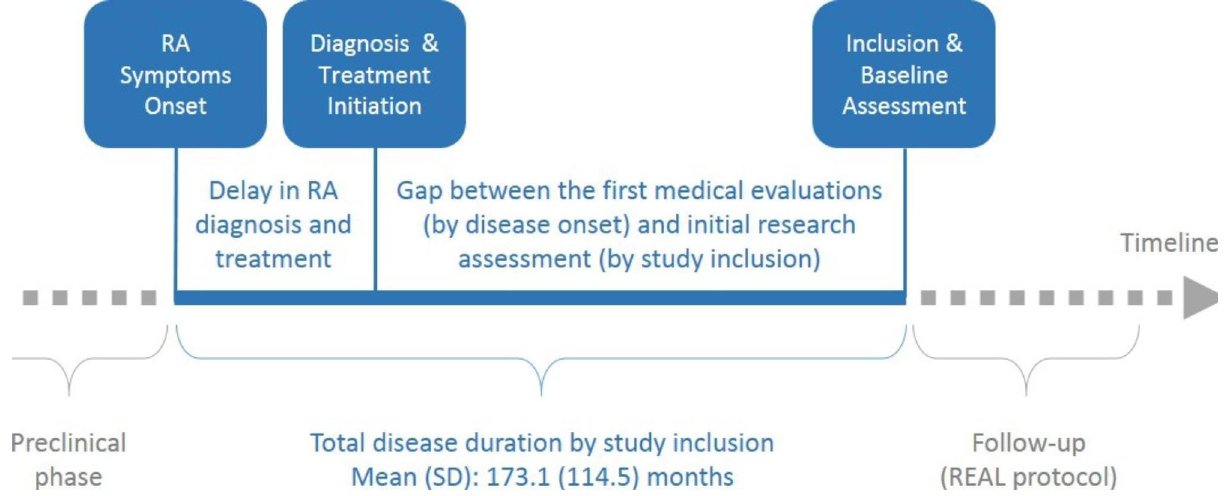
Fig. 1 Timeline of landmark events covered in the current study (blue